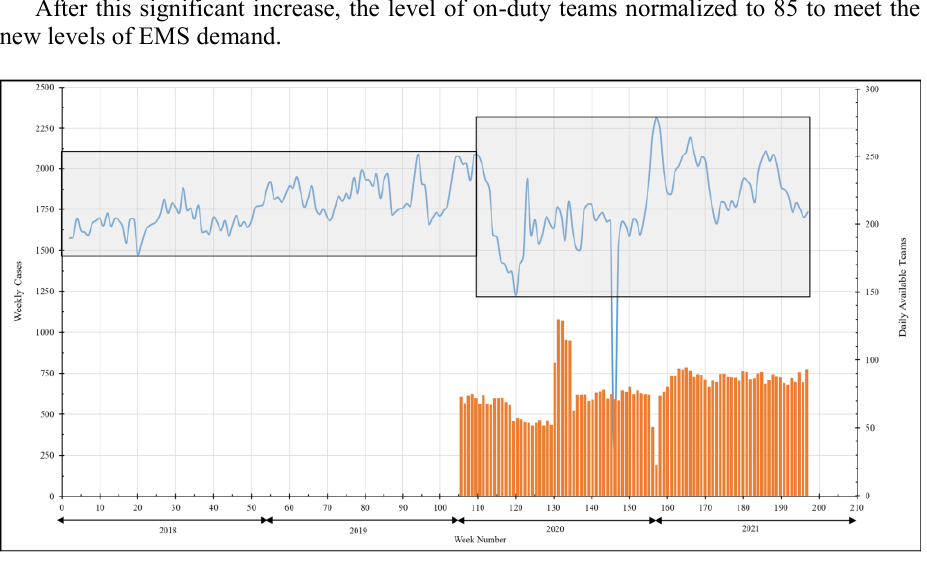
Fig. 6. Variation of Weekly Missions and Available